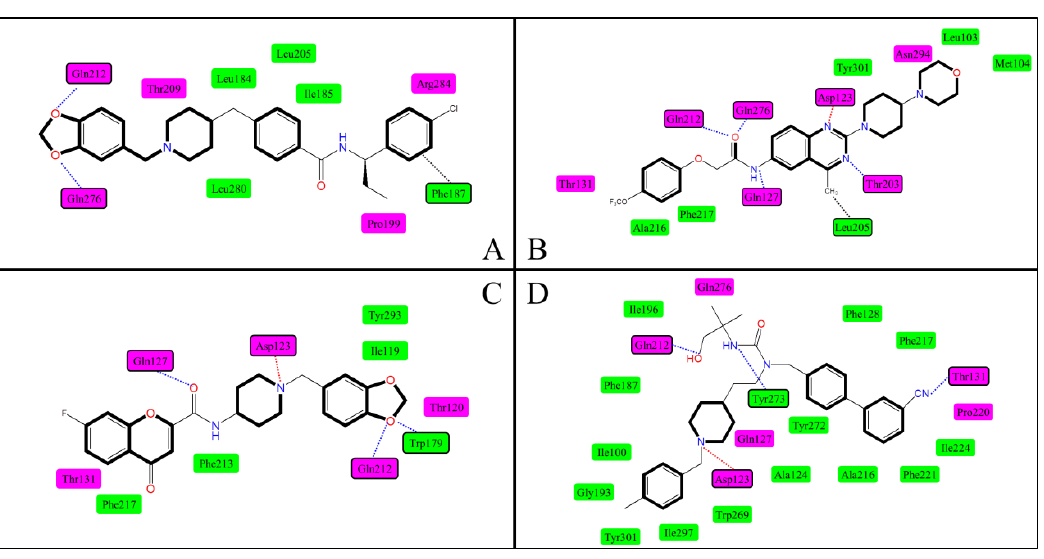
Figure 10. Binding modes of MCHR1selected from docking results performed by others. ( A ) The interaction map of P2 obtained by Abu-Hammad et al . [49]; ( B – D ) The interaction maps of P1 obtained by Sasmal et al . [29], Helal et al . [39] and Cirauqui et al . [43], respectively. H-bonds are shown as blue dashed lines, ionic interactions in red and van der Waals force in black. The green squares denote the hydrophobic residues and the pink signify the poly.